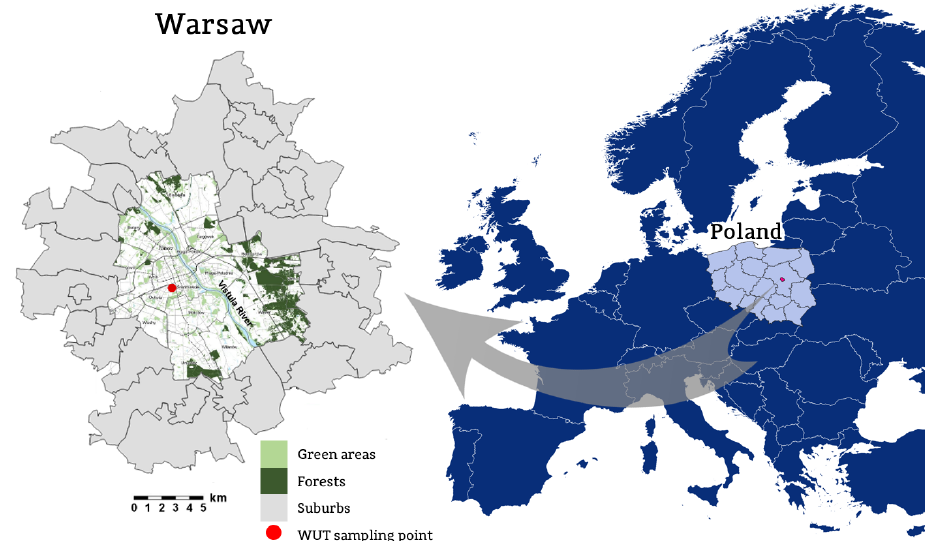
Figure 1. Location of the measurement site in